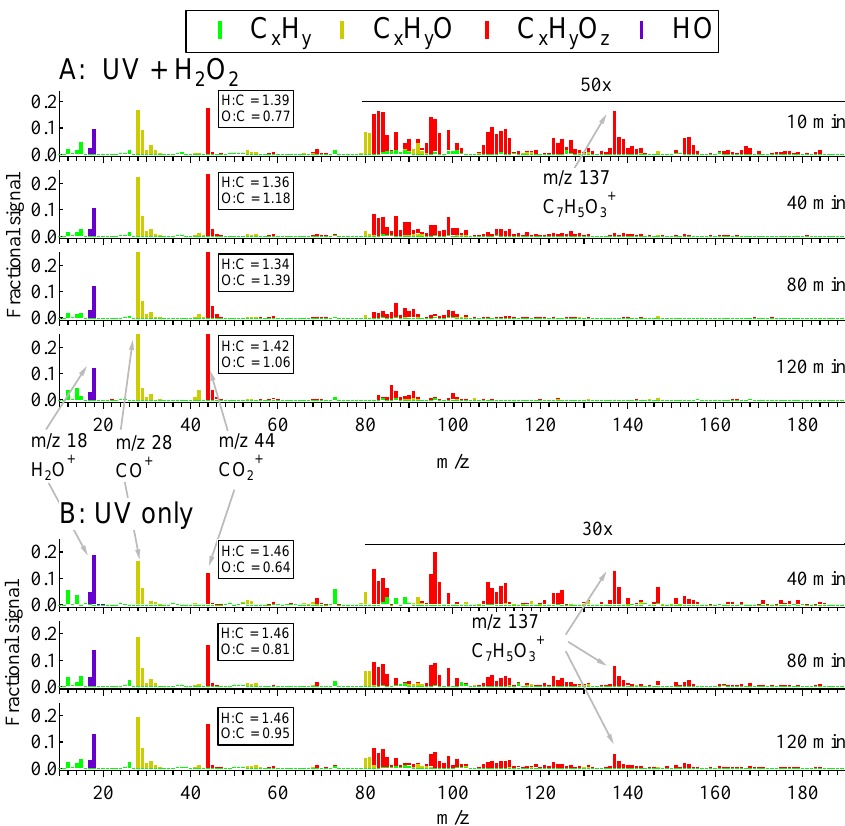
Fig. 2. Mass spectra at different reaction times under conditions (A) and (B), from experiments A_2 and B_2, respectively. The H:C and O:C ratios are also shown for each mass spectrum. Sticks with different colors indicate different ion “families”: C x H y being ions with only C and H, C x H y O being ions with C, H and only one O atom, C x H y O z being ions with C, H and more than one O atoms, and HO being ions with only H and O.